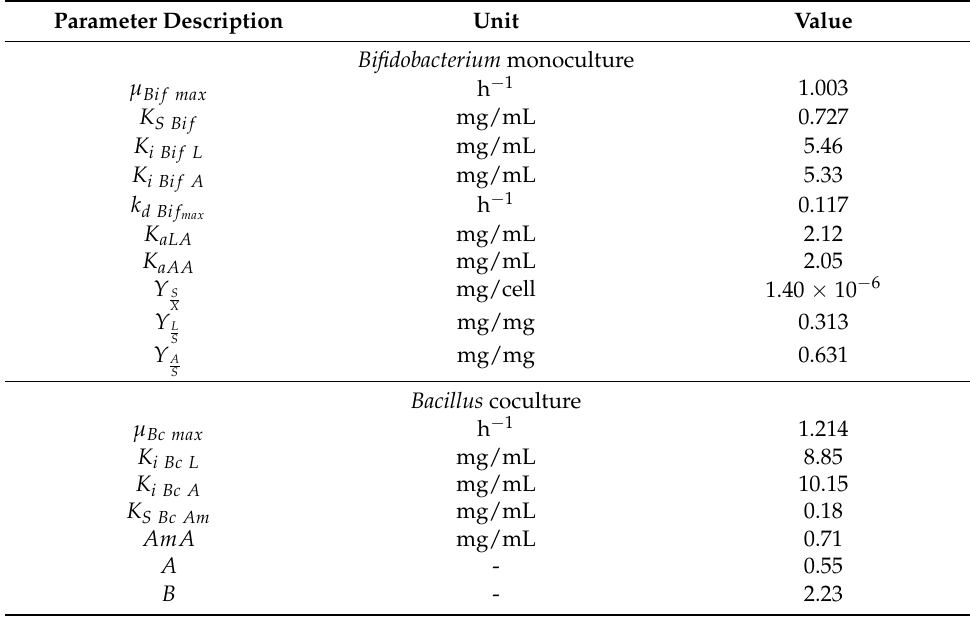
Figure 3. The correlations between OF consumption and LA and AA production at the stationary phase of Bifidobacterium monoculture. It was considered that the carbohydrates were consumed completely, and that the consumed substrate was equal to the introduced substrate. Table 1. The model parameter